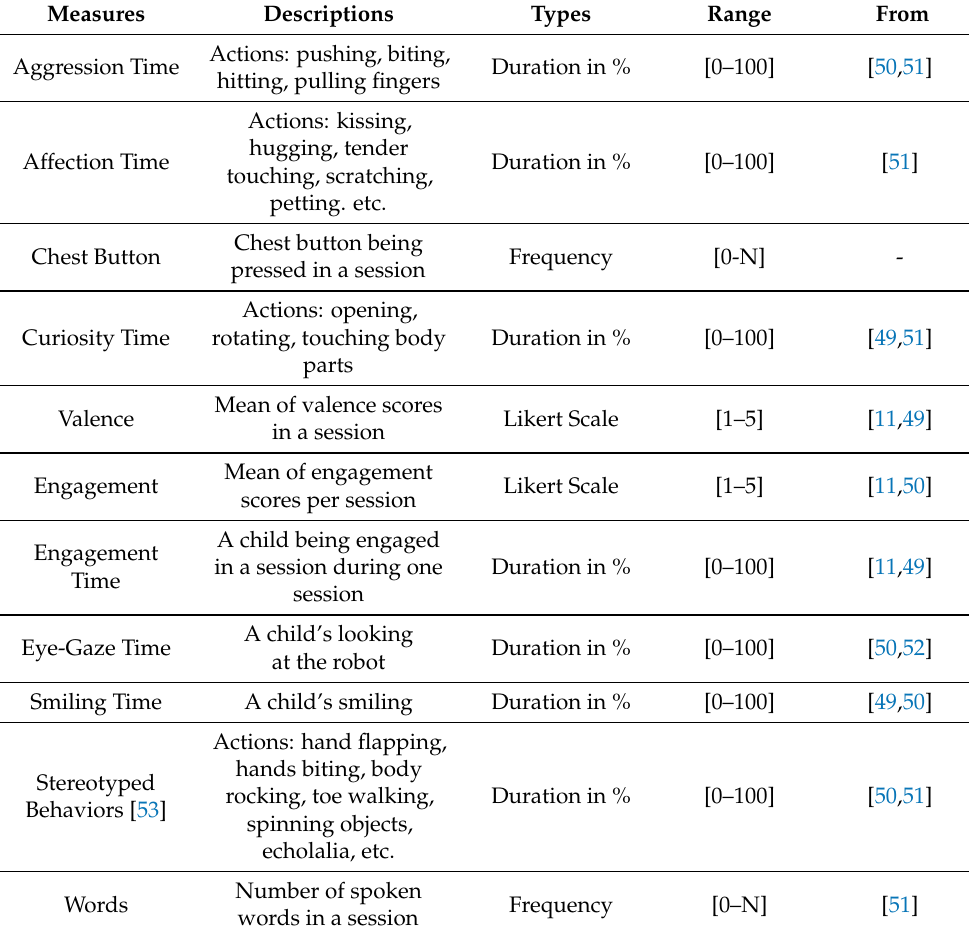
Table 2. The list of all measures and their